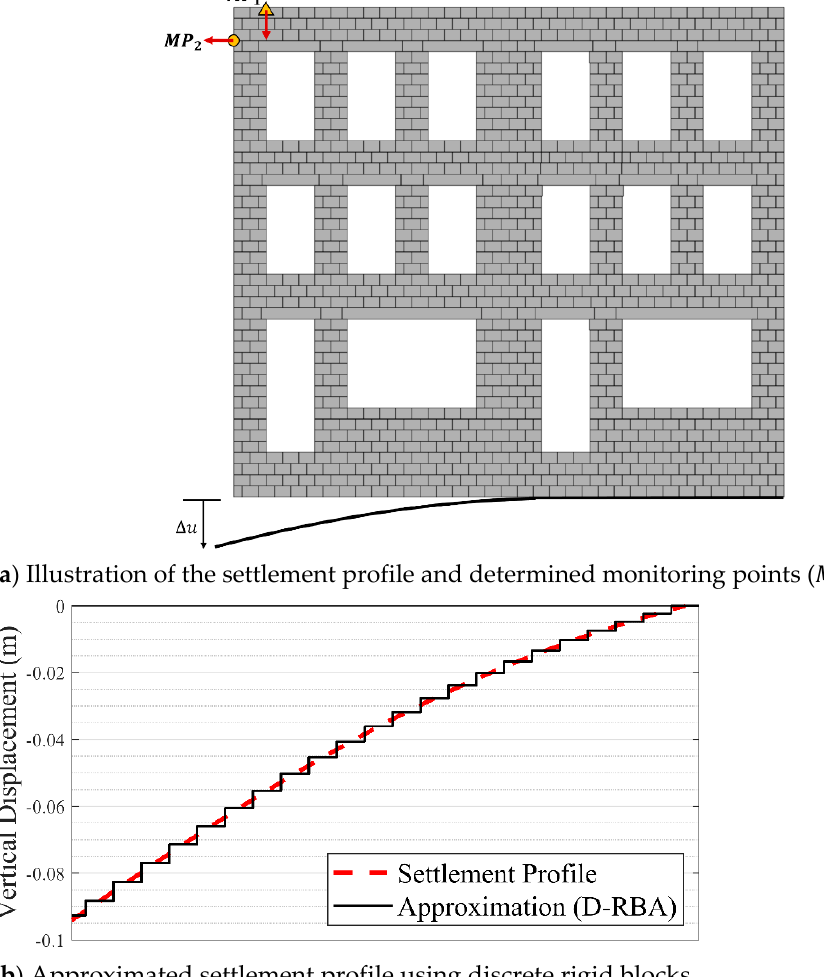
Figure 3. Representation of proposed discrete element model and applied for support settlement. The discrete rigid block models show similar trends compared to the experimental results given in Figure 4. The outcomes of this validation study show a strong similarity between the horizontal and vertical displacement histories, recorded from monitoring points ( 𝑀𝑃 (cid:2869) and 𝑀𝑃 (cid:2870) ), see Figure 4a. Moreover, observed crack pattern and global struc ‐ tural mechanism obtained from D ‐ RBA exhibit parallel behavior compared to experi ‐ mental findings presented in the reference study [5].